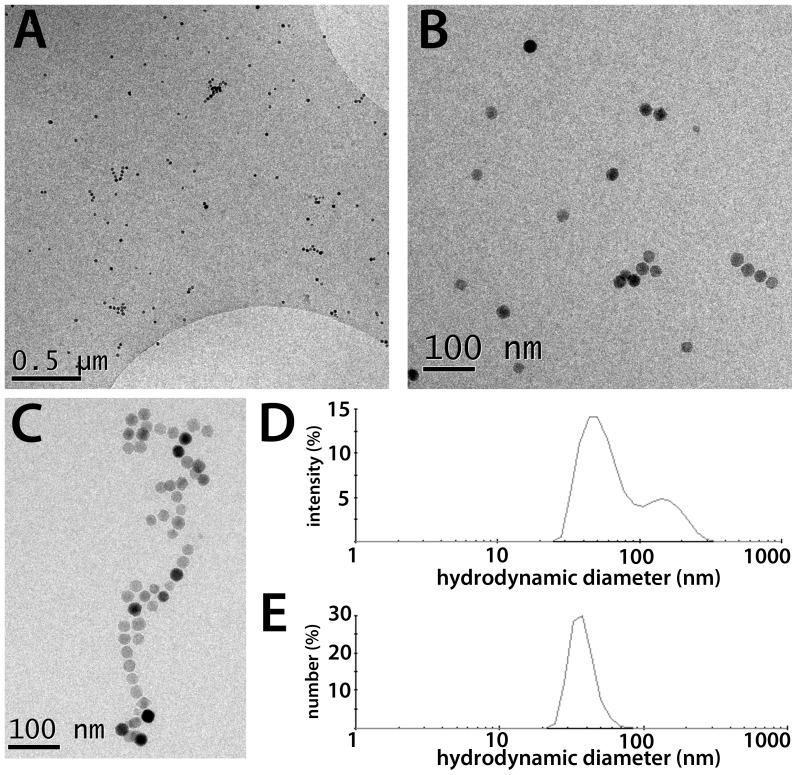
Cryo-TEM and DLS analysis of the ION-Micelles in HEPES buffered saline (HBS).(A,B) Typical Cryo-TEM micrographs of the ION-Micelles showing that the ION-Micelles are mostly dispersed as single particles or as small aggregates of particles in HBS. (C) Occasionally, larger ION-Micelle aggregates were observed. (D) Typical intensity-weighted and (E) number-weighted size-distribution profiles of the ION-Micelles obtained by dynamic light scattering measurements.